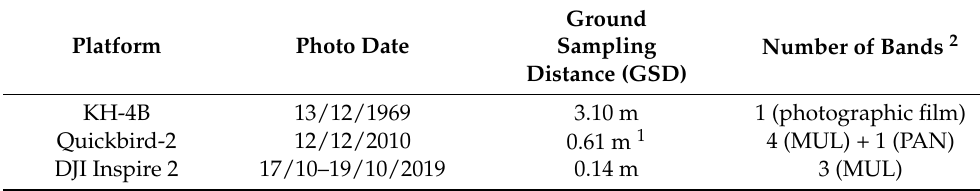
Table 1. Information for the images used in this